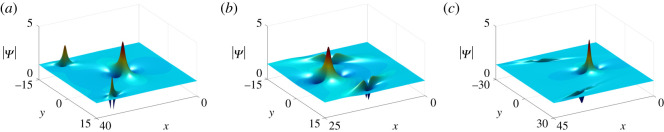
Three-lump solutions of equation (1.3) at t = 2 with parameter values κ = 1, a21 = b11, b21 = a11, p2 = q1, q2 = p1, q3 = p3, q1=p1∗, a11=b11∗, a11 = 0, p3 = 1/2, and (a) p1 = 1 + i/2, (b) p1 = 1/2 + i/2, (c) p1 = 1/2 + i.